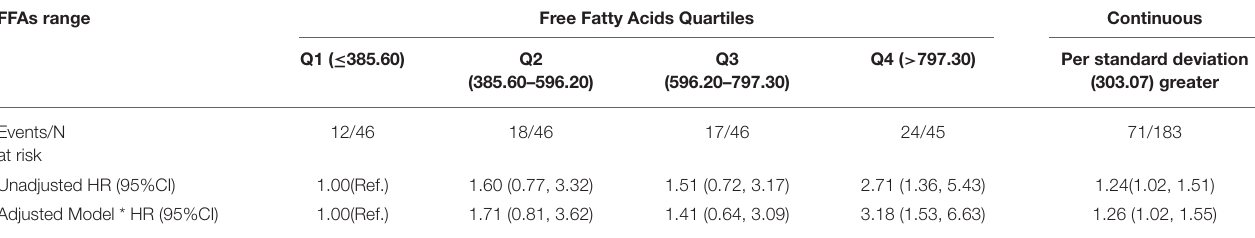
TABLE 3 | Univariate and multivariate Cox regression model for all-cause death or HF rehospitalization according to quartiles/standard deviation of serum free fatty acids. FFAs range